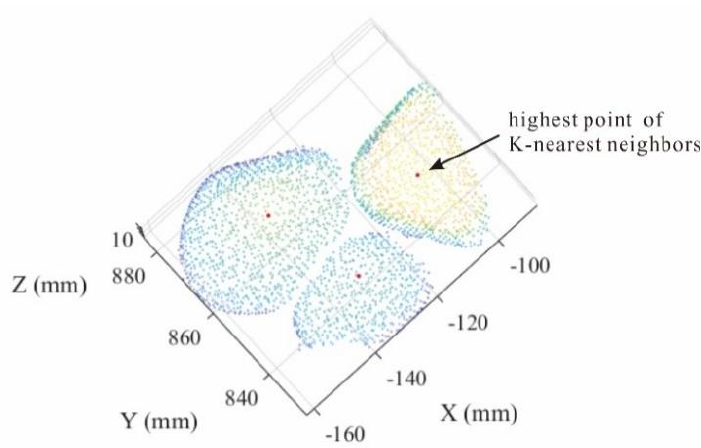
Figure 6. The highest point of K-nearest neighbors.